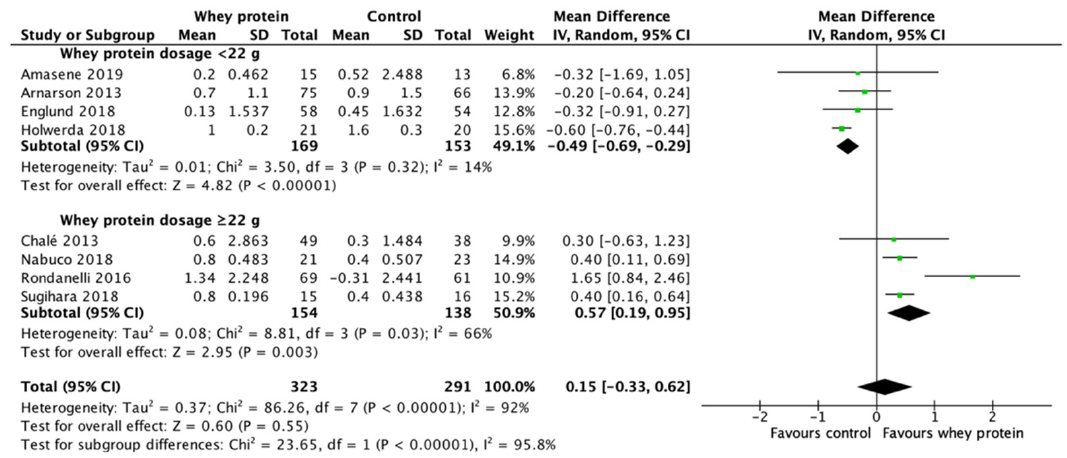
Figure 7. Forest plot for the differences in RT-induced LBM/FFM gain between consuming whey protein supplements and control supplements considering the subgroup analysis of protein dosage.